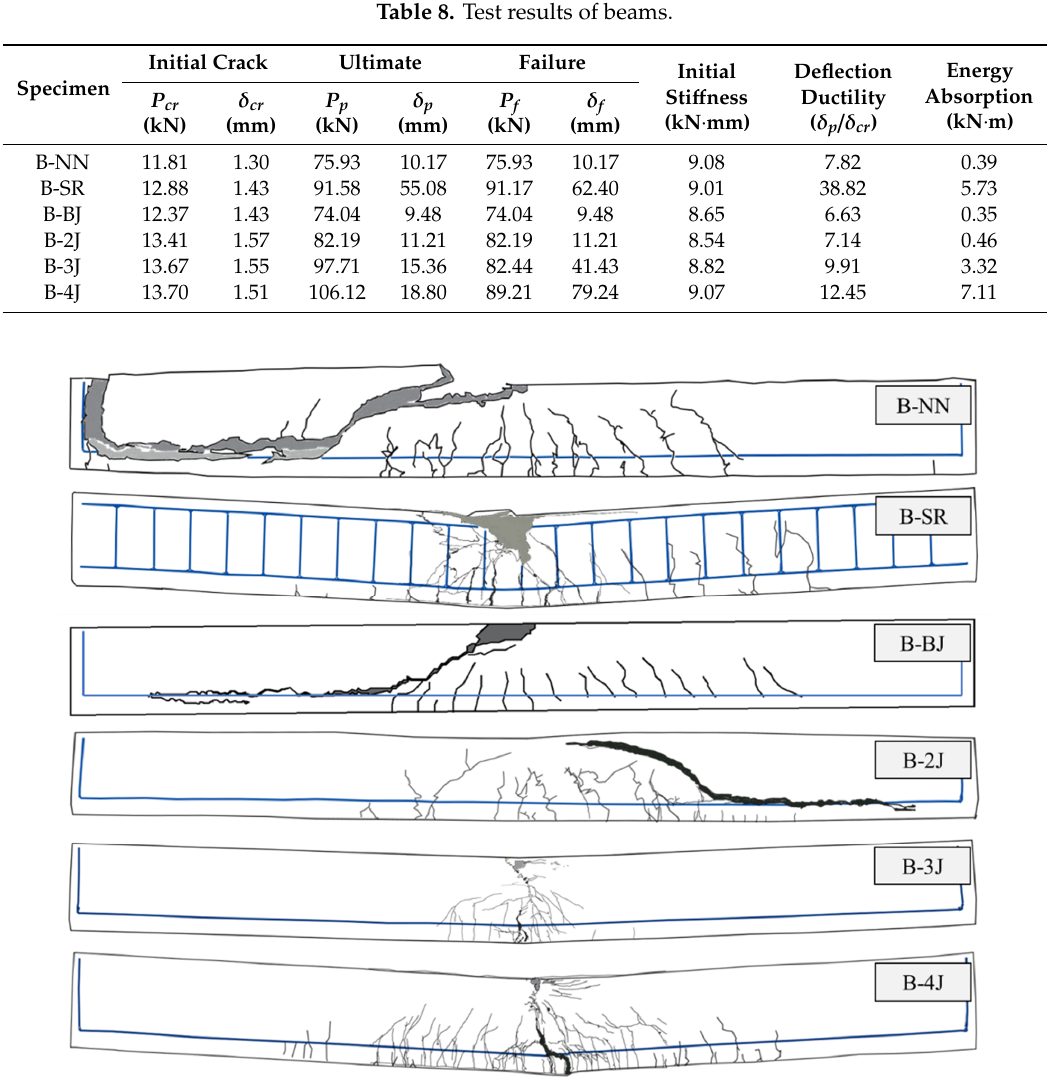
Figure 9. Crack distribution and failure mode of test beams.